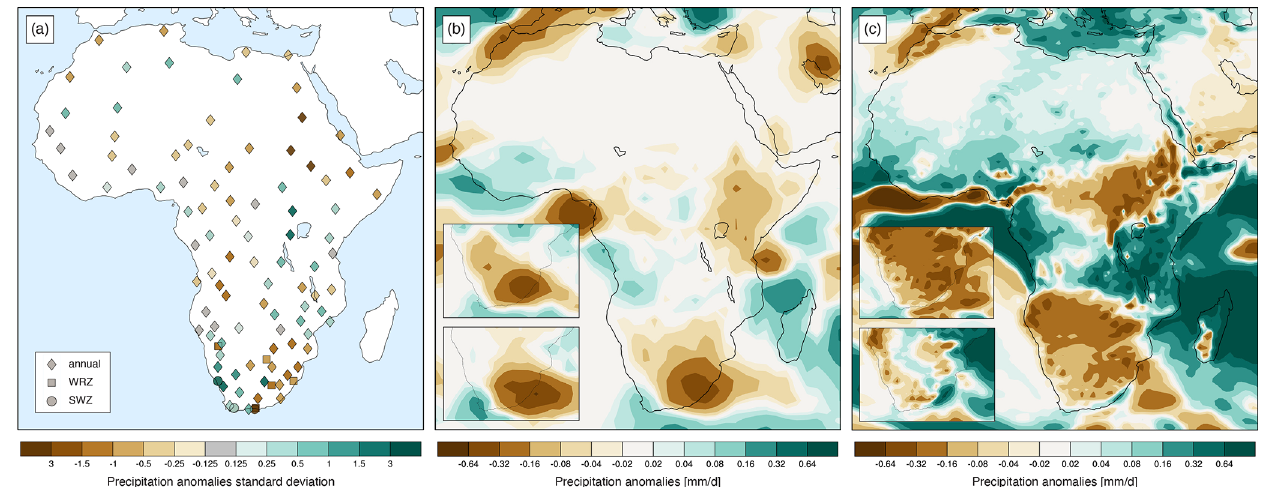
Figure 5. Precipitation composites of documentary records for the Global Drought 1877–1878CE (a) . Composites that are very close to 0 are colored grey (regardless of their sign). Composites of annual accumulated precipitation are shown for EKF400v2.0 (b) and 20CRv3 (c) . The superimposed graphs indicate composites for the SRZ (top) and the WRZ